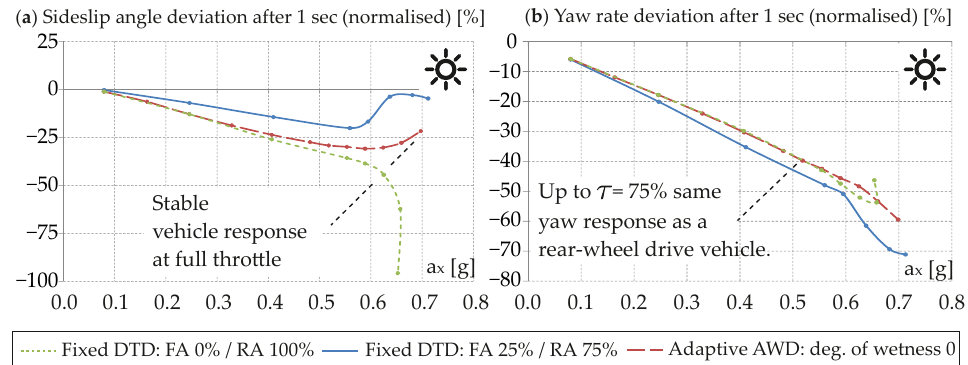
Figure 10. “Power On Cornering“ maneuver ( R = 60m , a y 0 = 6m/s 2 ) on dry road ( µ max = 1.0): ( a ) sideslip angle difference after 1s; ( b ) yaw rate difference after 1s.